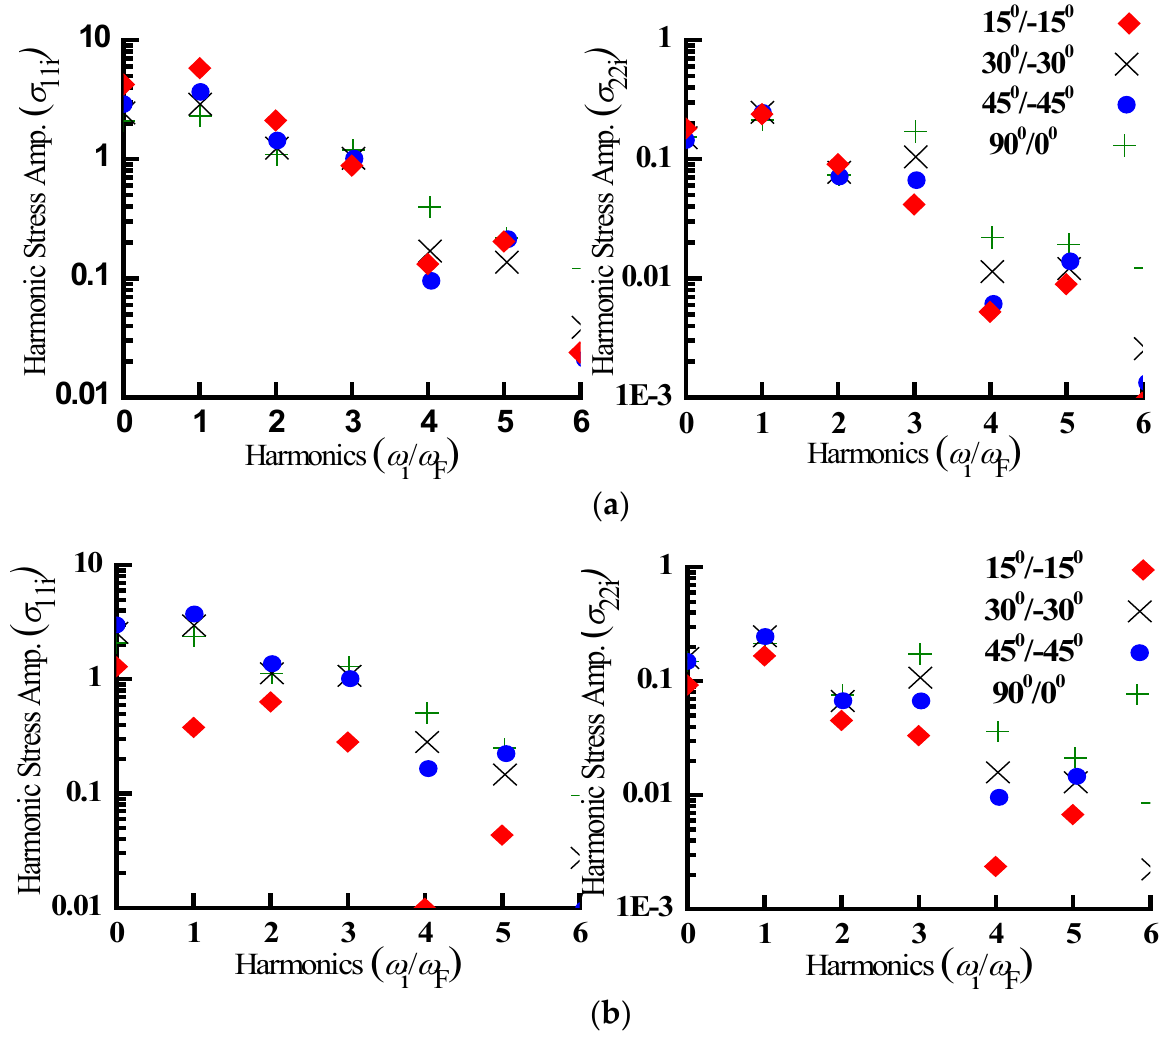
Figure 6. FFT of the steady-state stress referring to Figure 2 for top surface ( a ) and bottom surface ( b ), respectively.